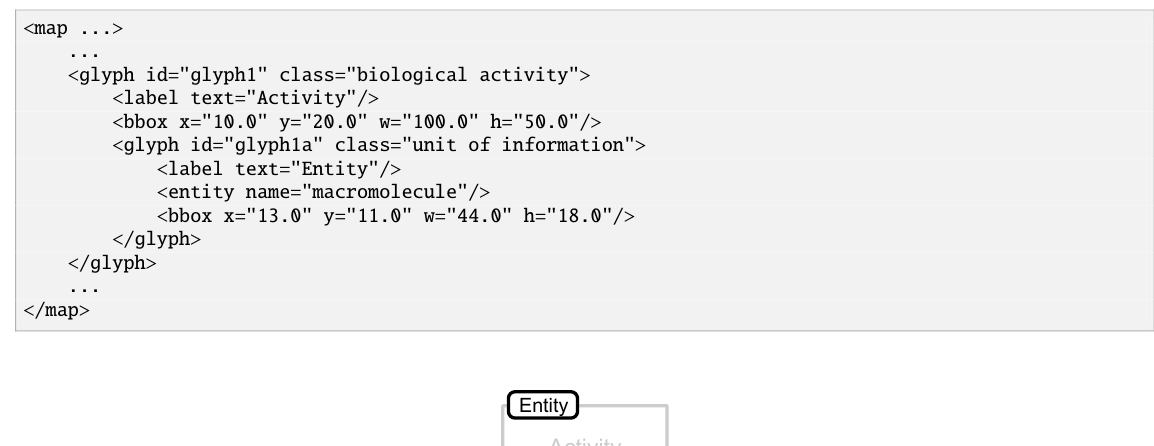
Figure 22: Visual representation of an Entity on a Glyph of the class biological activity .